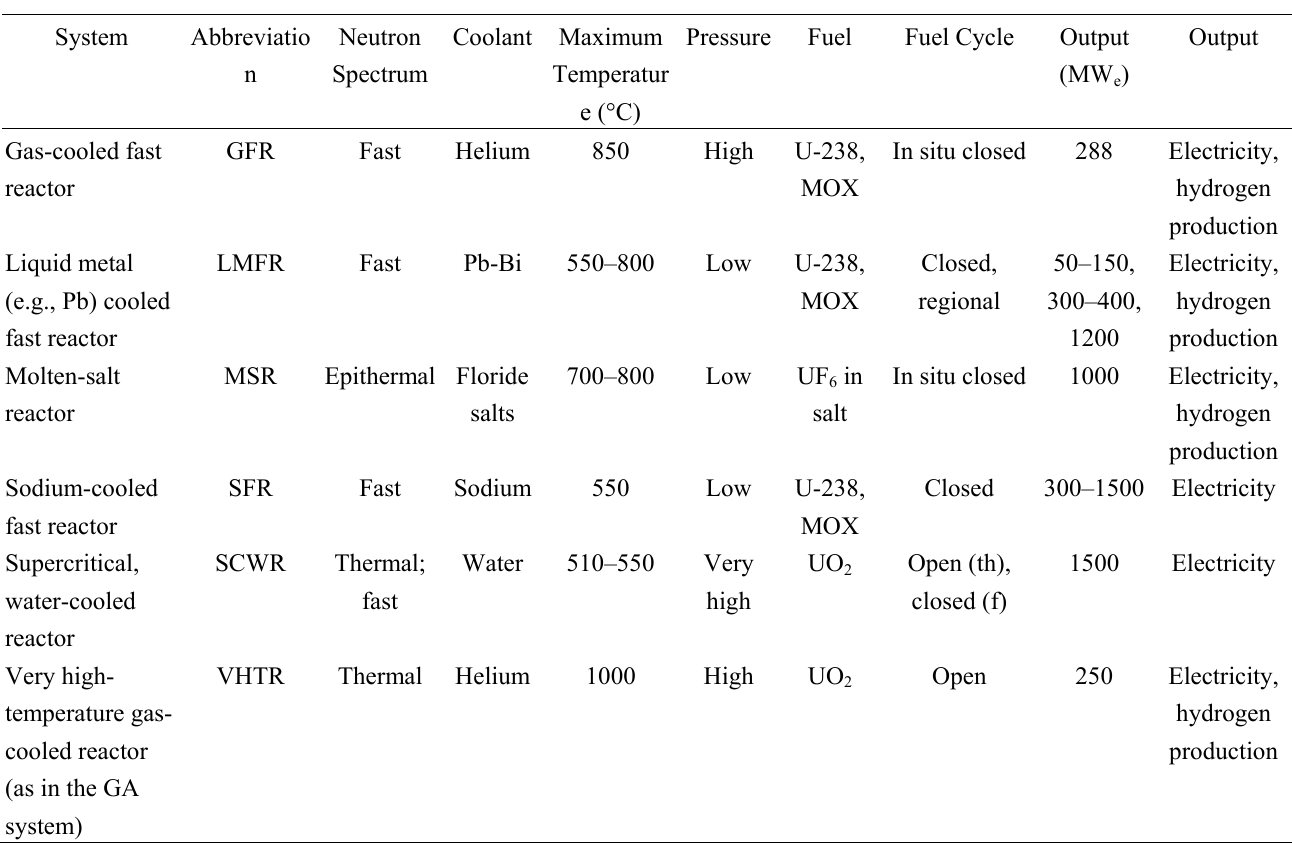
Table 4. Overview of Gen-IV reactor characteristics [133]. © 2008 Elsevier, reproduced with